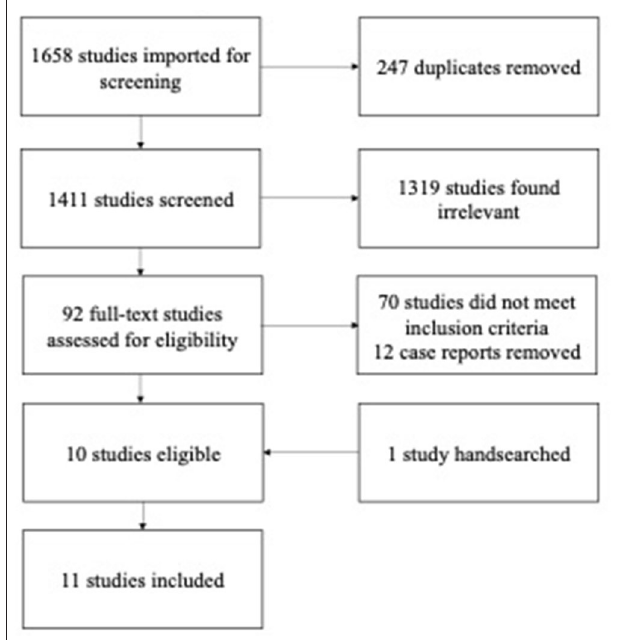
FIGURE 1 | PRISMA flow chart. A total of 1,658 studies were produced. Of these 247 duplicates were removed, and the remaining 1,411 studies were screened. After screening title and abstract 1,319 studies were found irrelevant, as they did not meet eligibility criteria. Seventy studies were excluded as they did not meet inclusion criteria after full-text screening, and 12 were case reports or case series. Finally 11 studies were